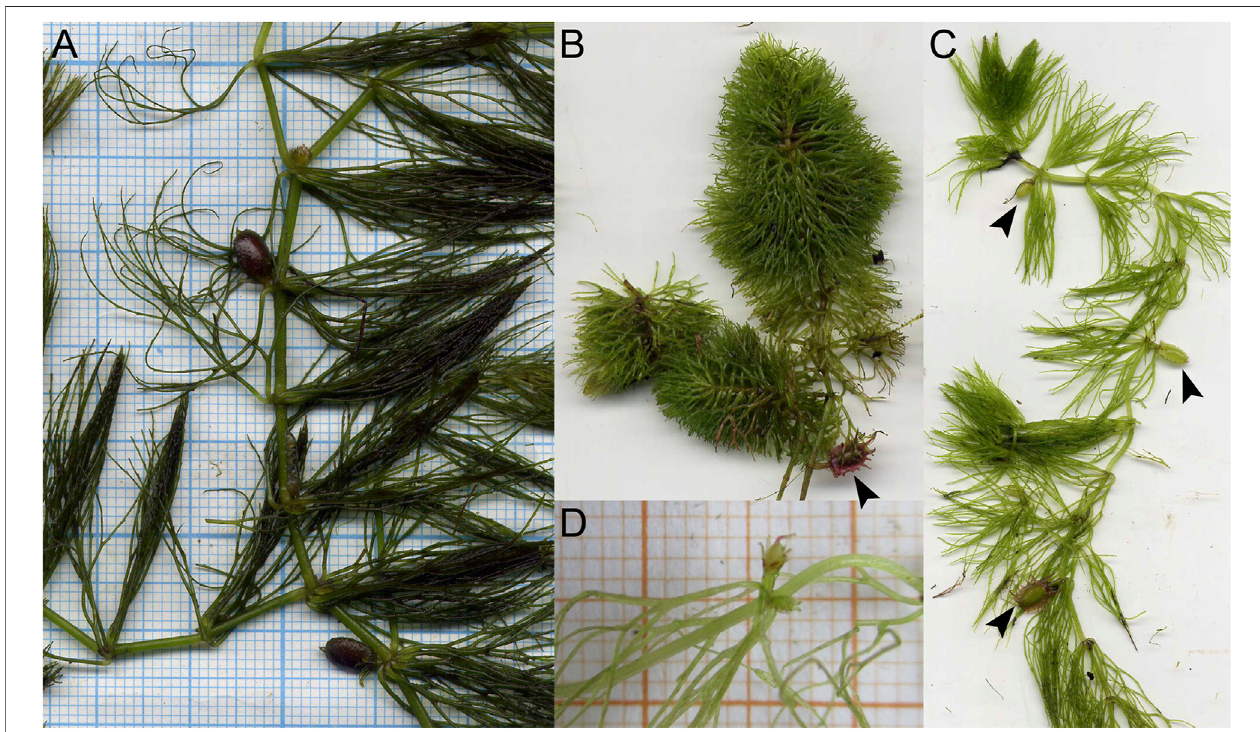
FIGURE1| Living plantsof Ceratophyllum spp.inKhoperStateNatureReserve,Russia(photos:E.V.Pechenyuk). (A) Ceratophyllumsubmersum ,portion ofplant withtwofruits,bothsessileandsmooth. (B) Terrestrialplantof C.tanaiticum withastalked,spinosefruit(arrowhead). (C) Aquaticplantof C.tanaiticum withthreefruitsat successive developmental stages (arrowheads). Fruit spines appear late in development. (D) Postanthetic pistillate fl ower of C. tanaiticum .